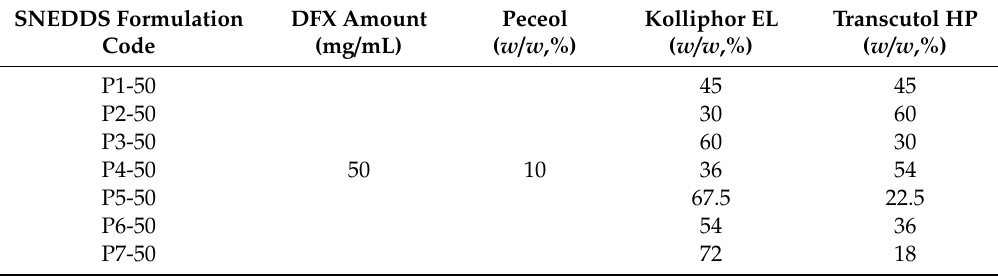
Table 8. Composition of the formulations prepared for further